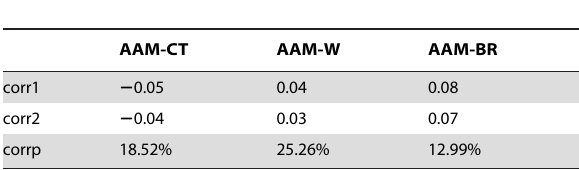
Table 4. Proportions of phenotype correlation explain correlations coefficients of three trait